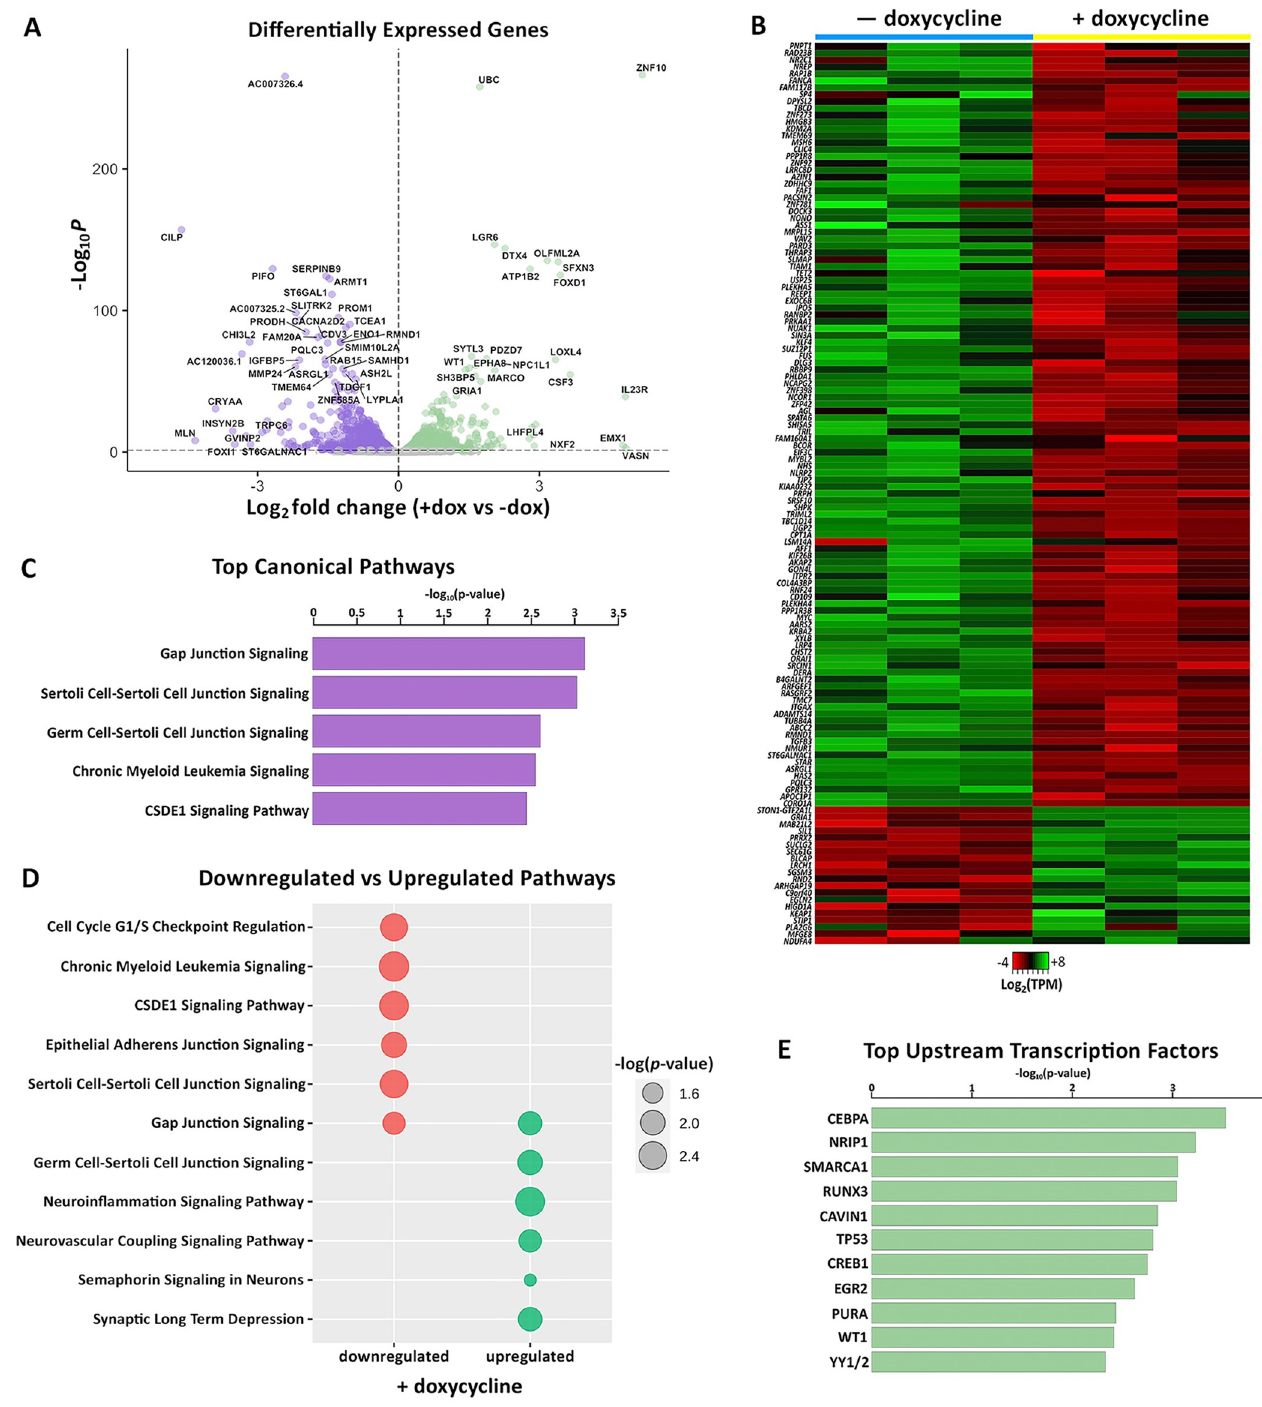
Fig 4. CRISPRi-mediated repression of conventionally de-repressed SVAs results in aberrant gene expression. (A) Volcano plot showing genes differentially expressed in SCi-NCCITs after doxycycline treatment (purple = downregulated genes; green = upregulated genes). (B) Heatmap of 131 genes that are differentially expressed post-doxycycline treatment and also represent the nearest gene to an SVA. (C) Top canonical pathways predicted by IPA for the 131 genes differentially expressed after doxycycline treatment. (D) Canonical pathways predicted by IPA for the 111 downregulated (red) and 20 upregulated (green) genes. (E) Top upstream regulators/transcription factors predicted by IPA for the 131 genes differentially expressed after doxycycline treatment.